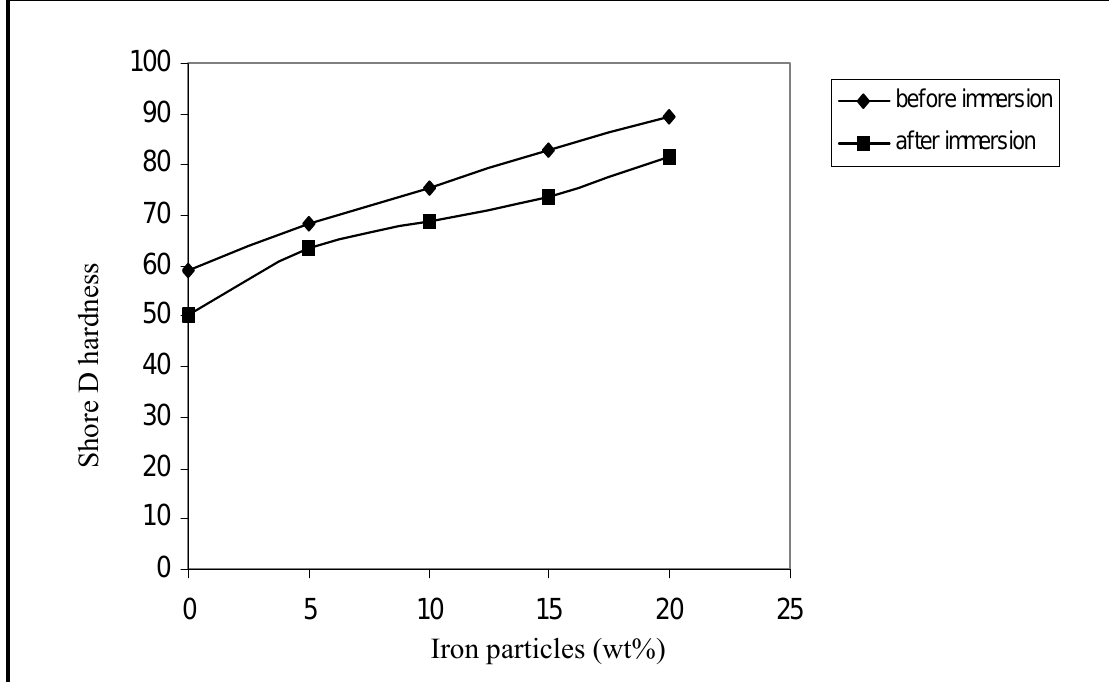
Fig. 1: Shore D Hardness values as a function of Iron